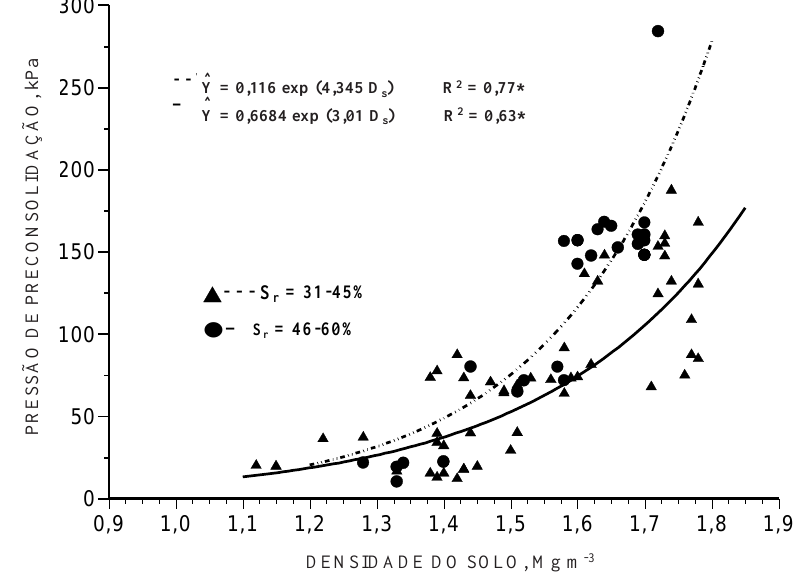
Figura 2. Valores de pressão de preconsolidação para o Argissolo, considerando a densidade do solo para os graus de saturação (S ) de 31 a 45% e 46 a r